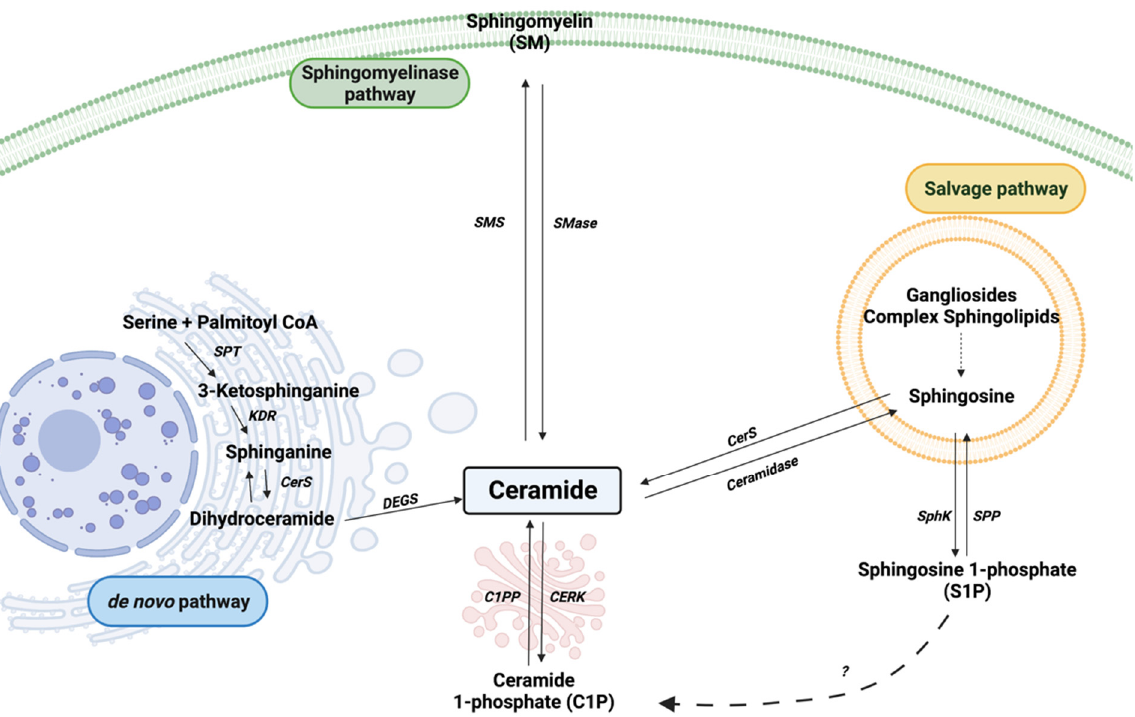
Figure 1. Sphingolipid metabolism. Sphingomyelinase (SMase), sphingomyelin synthase (SMS), serine palmitoyl transferase (SPT), 3-ketosphinganine reductase (KDR), ceramide synthase (CerS), dihydroceramide desaturase (DEGS), sphingosine kinase (SphK), sphingosine 1-phosphate phosphatase (SPP), ceramide 1-phosphate phosphatase (C1PP), and ceramide kinase (CERK) are represented by their acronyms. The dashed arrow with interrogation mark represents a putative mechanism for C1P generation from S1P.